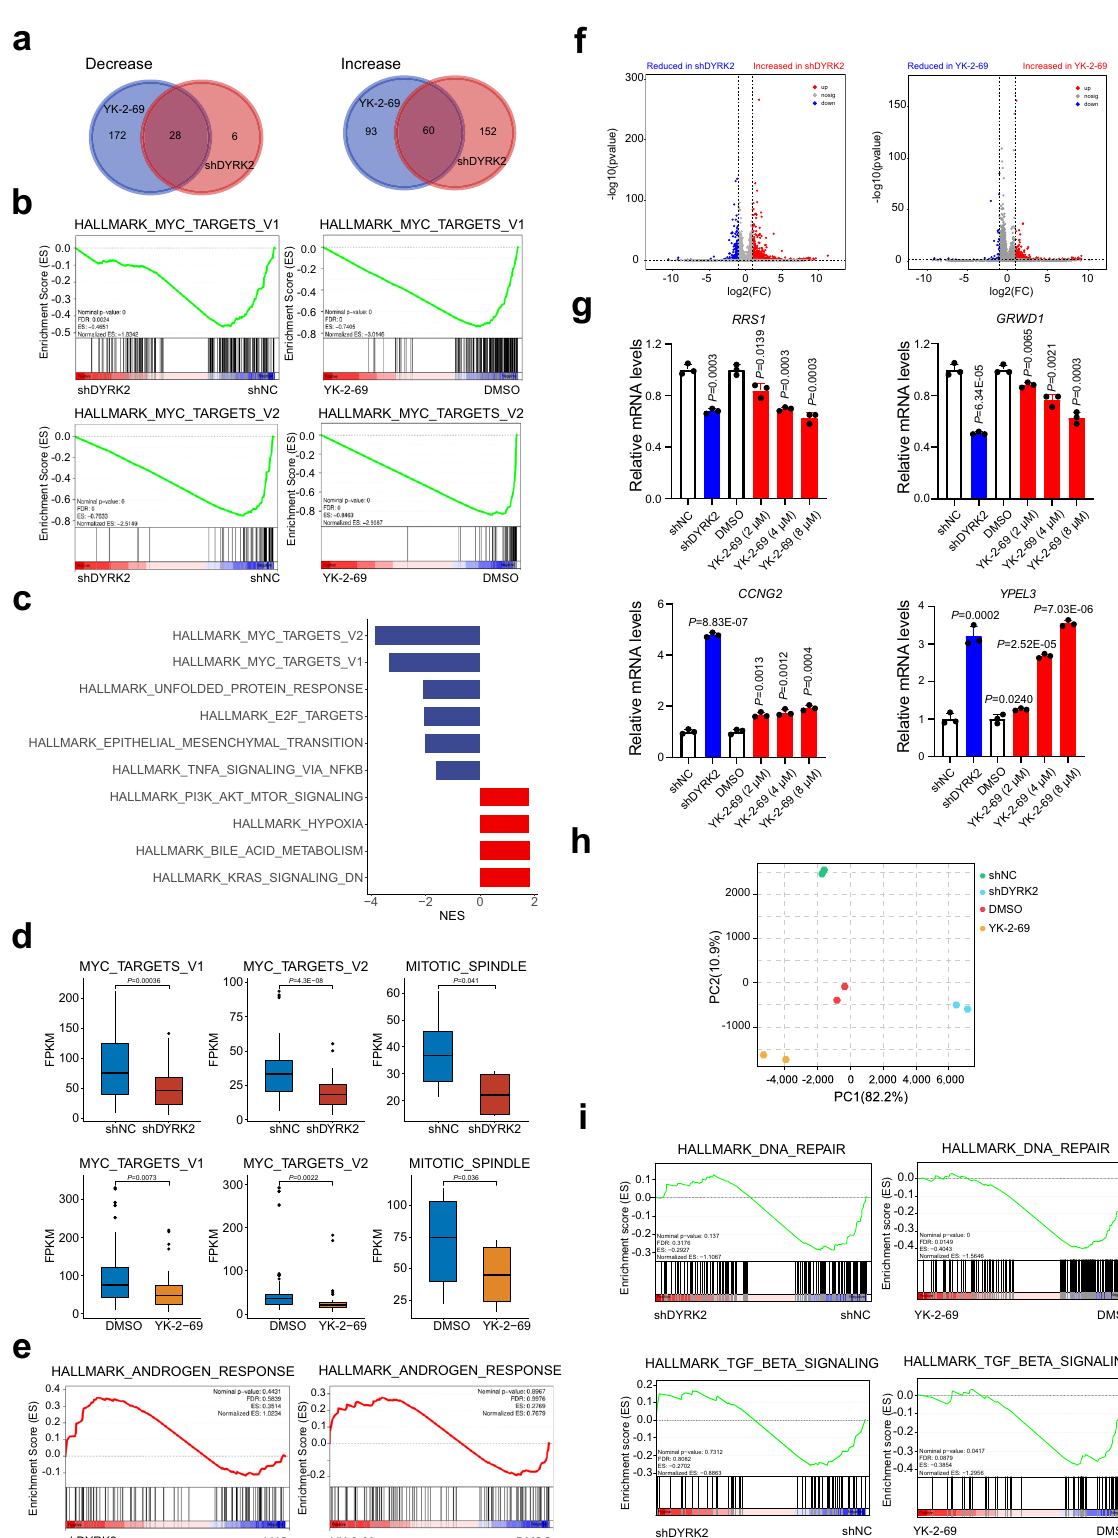
Through the analysis of differentially expressed genes (DEG) between shDYRK2 and YK-2-69-treated samples in transcriptome-wide RNA-sequencing (Fig. 6f and Supplementary Dataset 1) and the further experiment con fi rmation, we found signi fi cant expression changes in human regulator ribosome synthesis 1 ( RRS1 ), glutamate-rich WD40 repeat containing